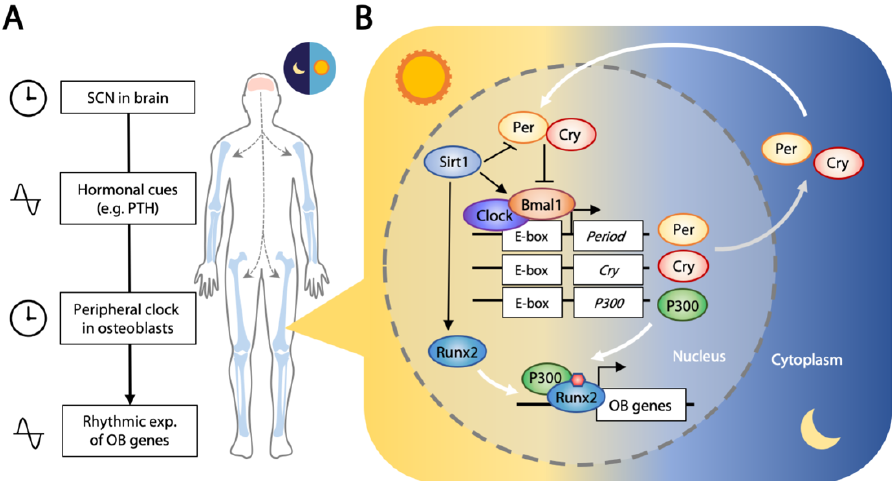
Figure 3. Circadian clock in bone. ( A ) Suprachiasmatic nucleus (SCN) in the hypothalamus